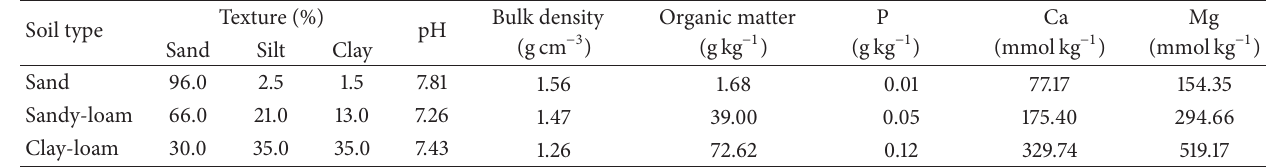
Table 1: Soil characteristics for the three soil types in which J. curcas seedlings were grown for three months.